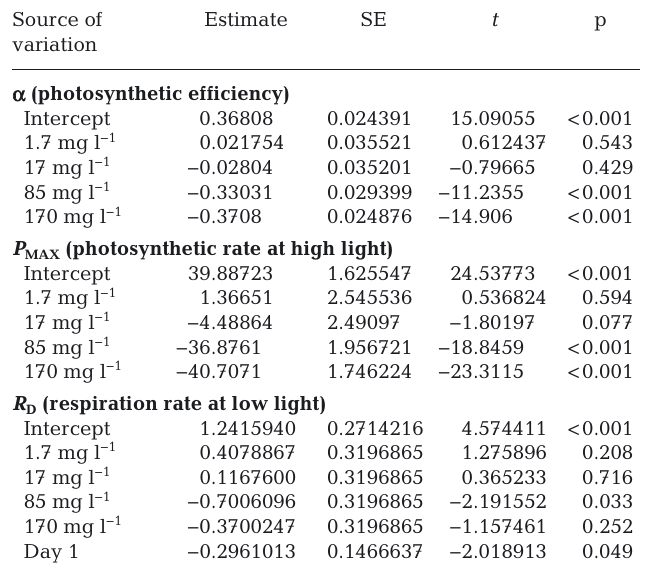
Table 3. Estimated regression parameters (H 2 O 2 concentration, and time), standard error (SE), t -values, and p-values from generalized least squares (GLS) models fitted to the photosynthetic response vari- ables. Only significant terms were included in the final